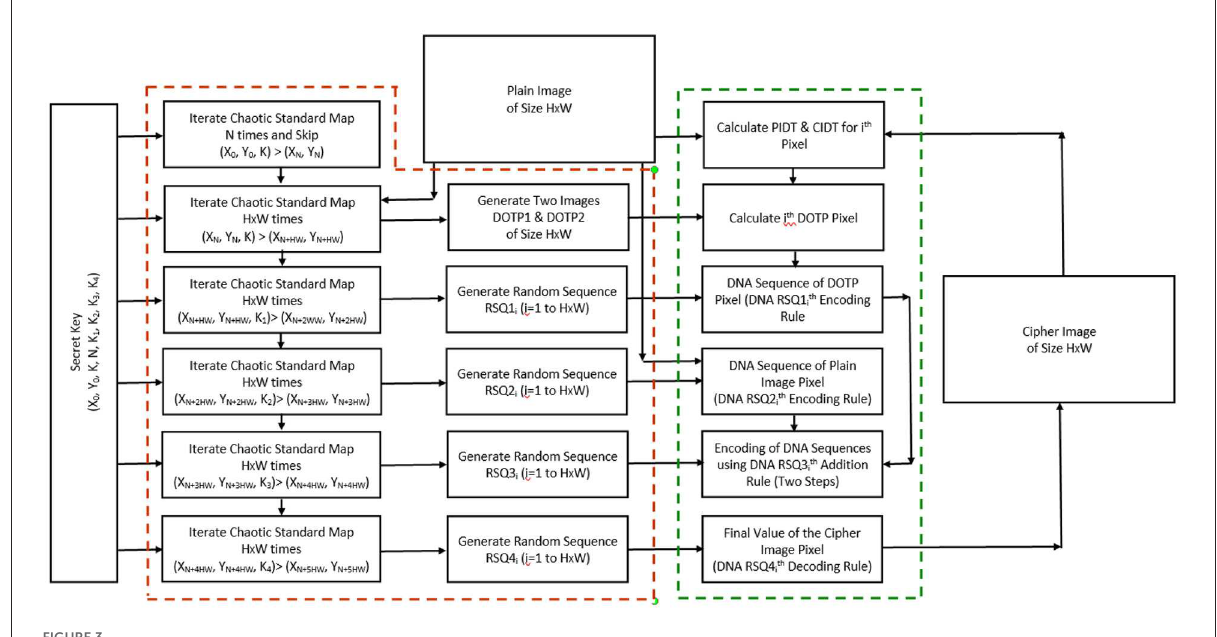
FIGURE3 Block diagram of the proposed image encryption